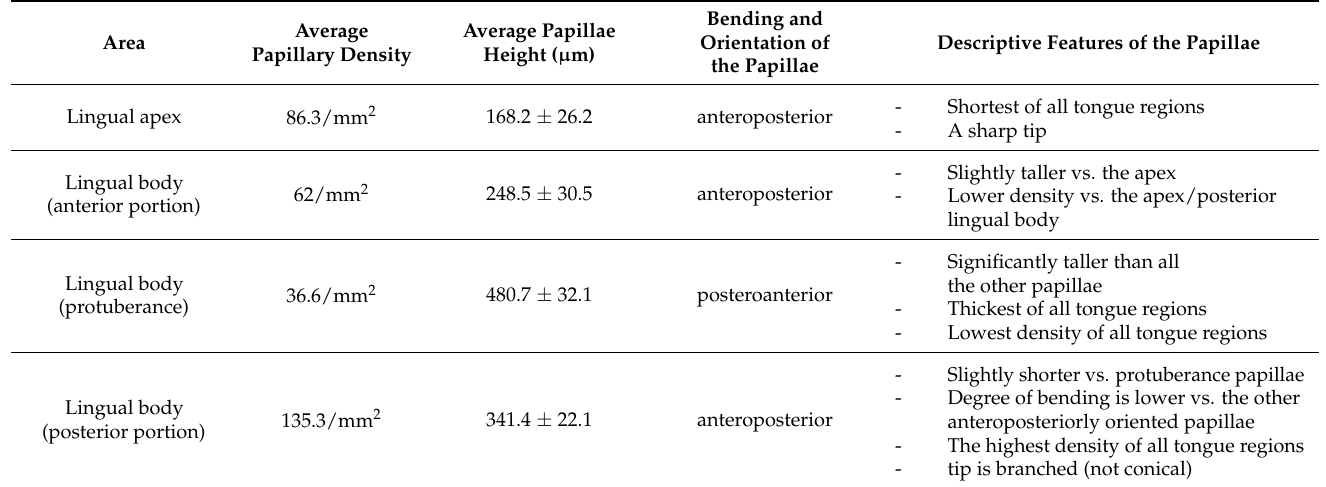
Table 1. The features of filiform papillae in all the regions of the